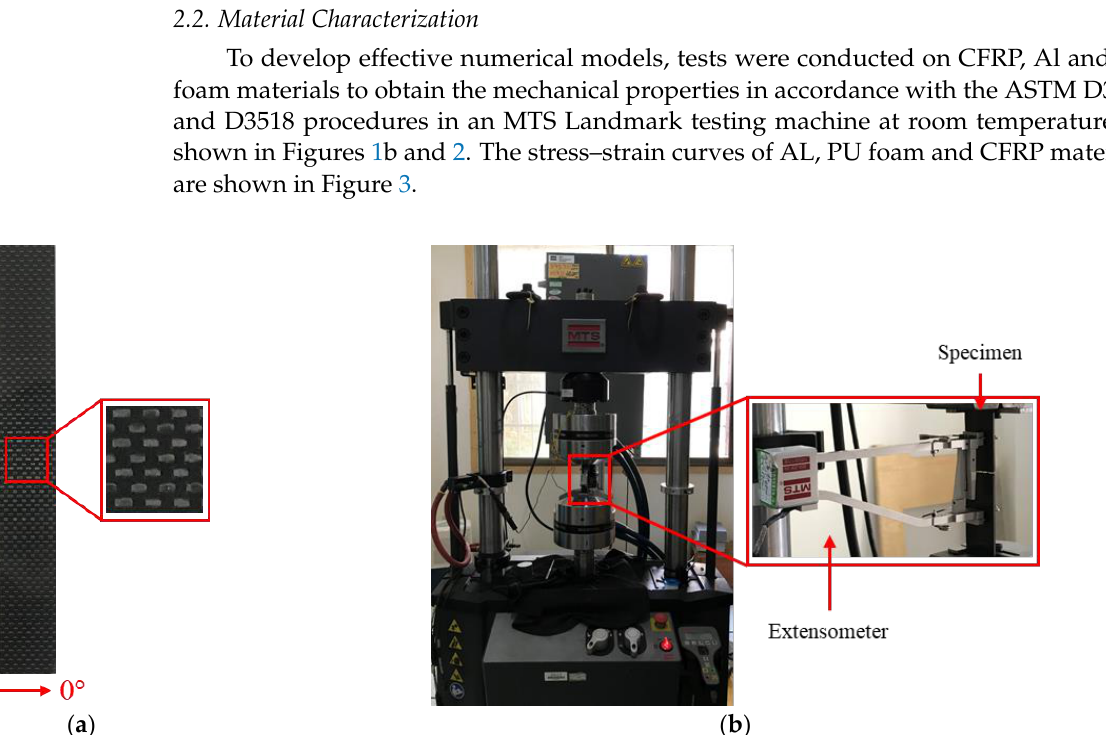
Figure 1. Preparation of specimens and quasi-static compression tests. ( a ) Four foam-filled hybrid structures; ( b ) qua- si-static compression test configuration.